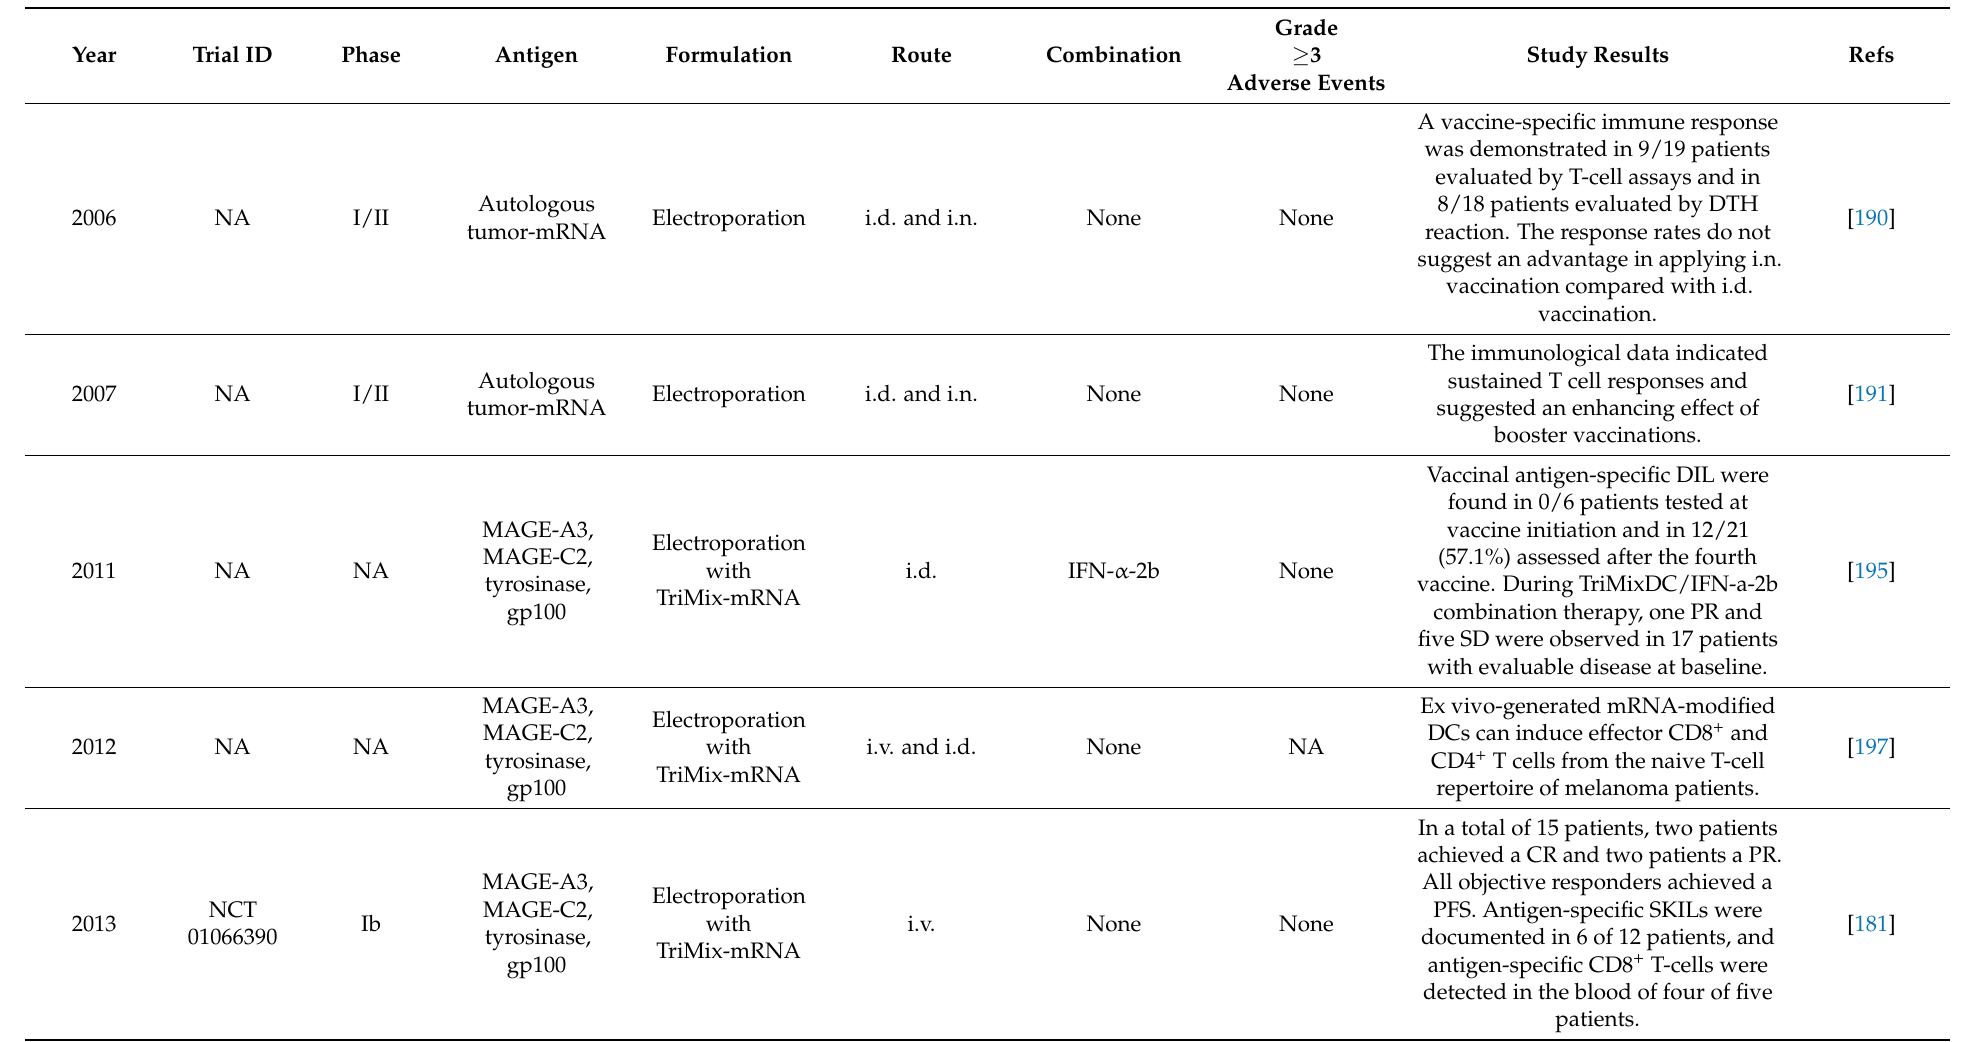
Table 2. Completed clinical trials of DC-based mRNA vaccines against